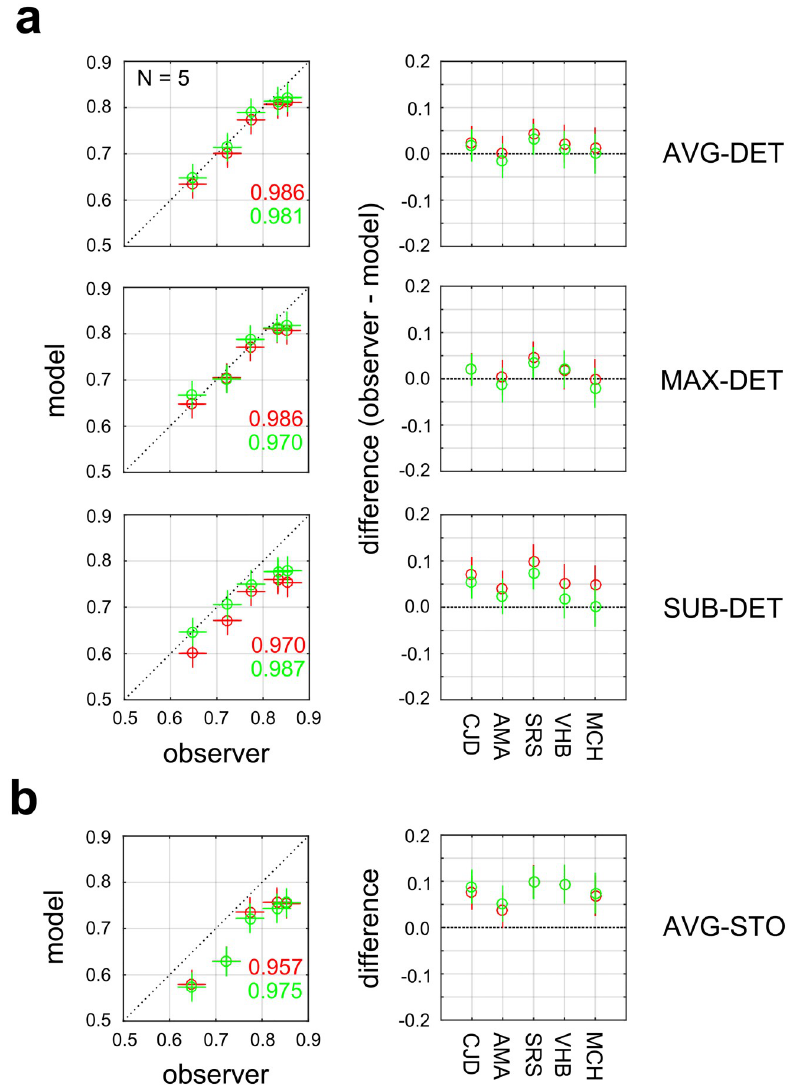
Fig 8. Double-pass analysis for 5 observers in Experiment 1-VAR. ( a ) Models operating in deterministic (DET) mode for three different downsampling rules. Left panels : Observer-observer (horizontal axis) and observer-model (vertical axis) proportion agreement on the double-pass set. Error bars denote 95% binomial proportion confidence intervals. Right panels : Difference between observer-observer and observer-model proportion agreement for each of 5 observers. Error bars denote 95% binomial proportion difference confidence intervals. ( b ) Same as (a), but for model with AVG downsampling operating in stochastic mode (AVG-STO).